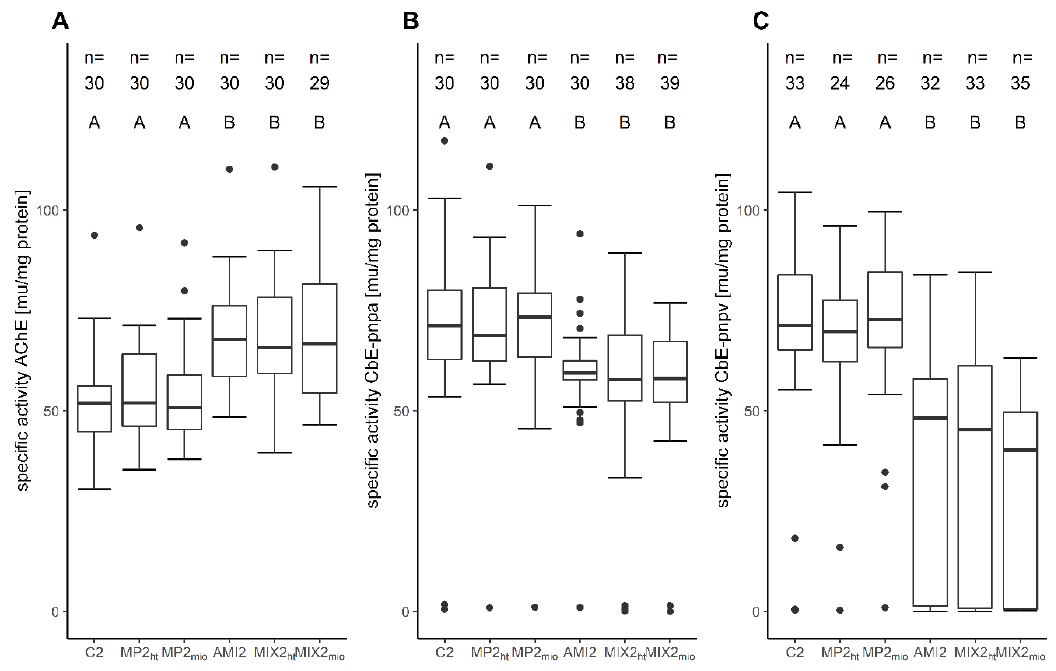
Figure 7. Enzyme activity in brown trout fry exposed to microplastic particles (MP), amitriptyline, or the mixture of both. ( a ): Specific activity of acetylcholinesterase (AChE). ( b ): Specific activity of carboxylesterases (CbE) with the substrate pnpa. ( c ): Specific activity of CbE with the substrate pnpv. The box plots display the median, the 25th and 75th percentiles as well as minimum and maximum values (whiskers); the dots indicate outliers. Different letters indicate significant differences.